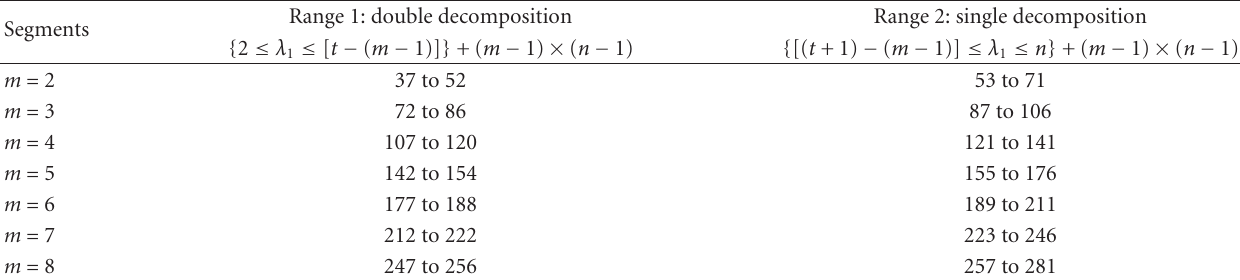
Table 1: Decomposition of input bit sizes for large size multipliers.